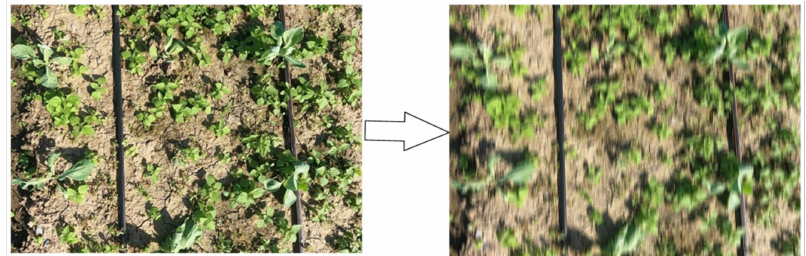
Figure 4. Motion blur